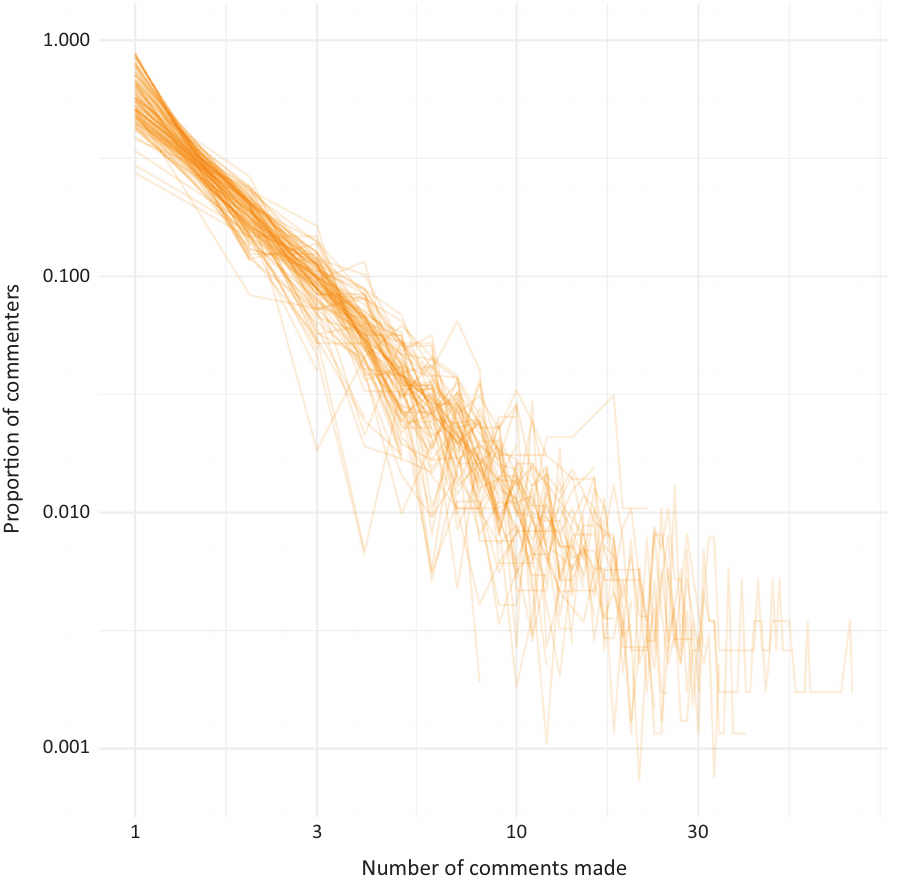
Figure 2. Distribution of comments per member across 100 randomly selected subreddits on Reddit in January 2017. Notes: The y‐axis (log‐scaled) shows the proportion of users making each number of comments (log‐scaled); every community exhibits a very similar shape, with the lion’s share of commenters only making a few comments. Before plotting, the top 5% of participants were removed in order to remove the influence of highly active bots or incredibly active users and to highlight the similarity of “typical” users across these